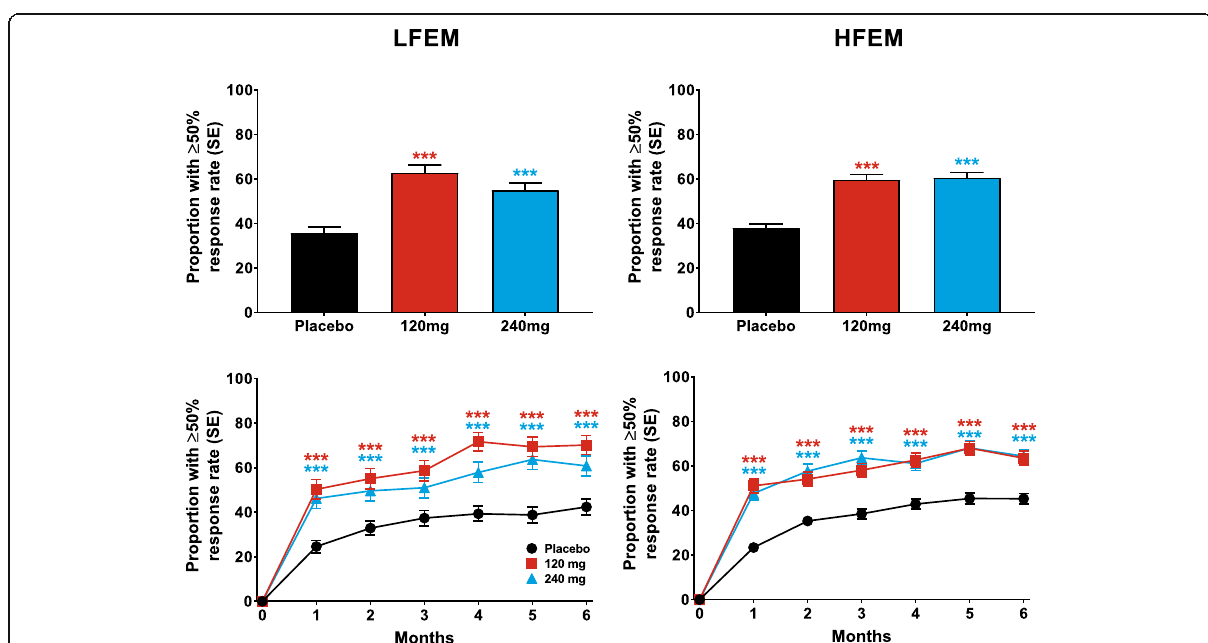
Fig. 2 The overall mean percentage of patients with ≥ 50% reduction from baseline in monthly MHDs across Months 1 – 6 is shown for patients with LFEM and HFEM receiving placebo, 120-mg, or 240-mg of galcanezumab in the upper row. The monthly percentage of patients with ≥ 50% reduction in MHDs is shown in the bottom row for patients with LFEM and with HFEM. ***p ≤ .001, **p ≤ .01, *p ≤ .05 vs placebo